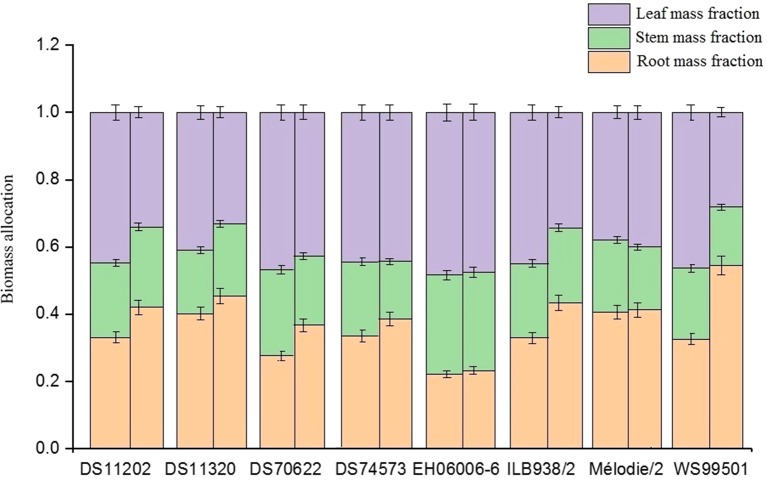
Biomass allocation to root, stem, and leaf mass fractions in eight faba bean accessions. The left bar shows the well-watered treatment, and the right side shows the water-limited treatment.